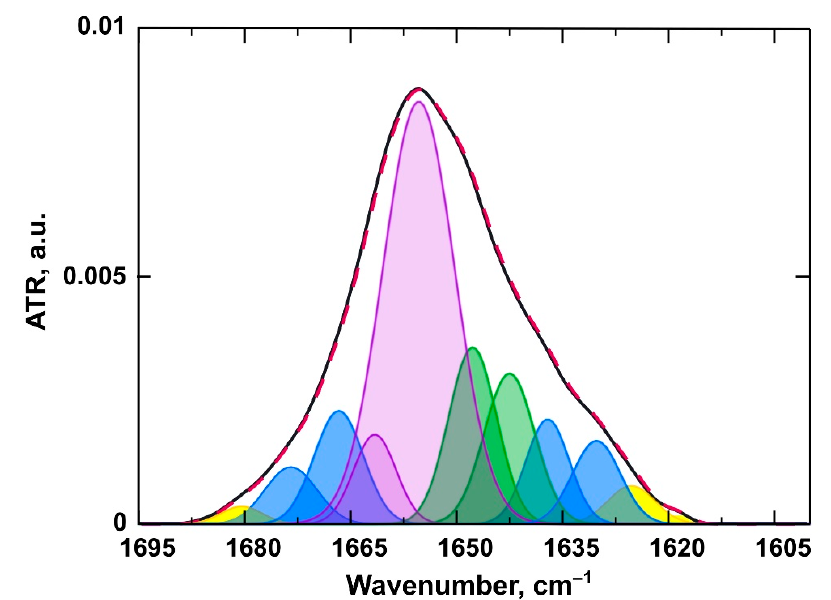
Figure 6. An example of the amide I band of a BSA spectrum (black line) and deconvolution components (purple, α -helix; green, random coil; blue, β -turns and sheets; yellow line, aggregates) with resulting fitting curve shown as a red dashed line.